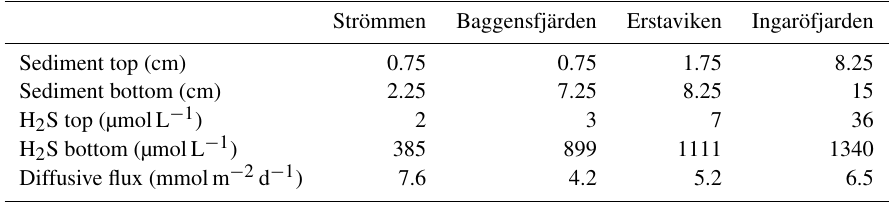
Table 3. Diffusive fluxes of pore water H 2